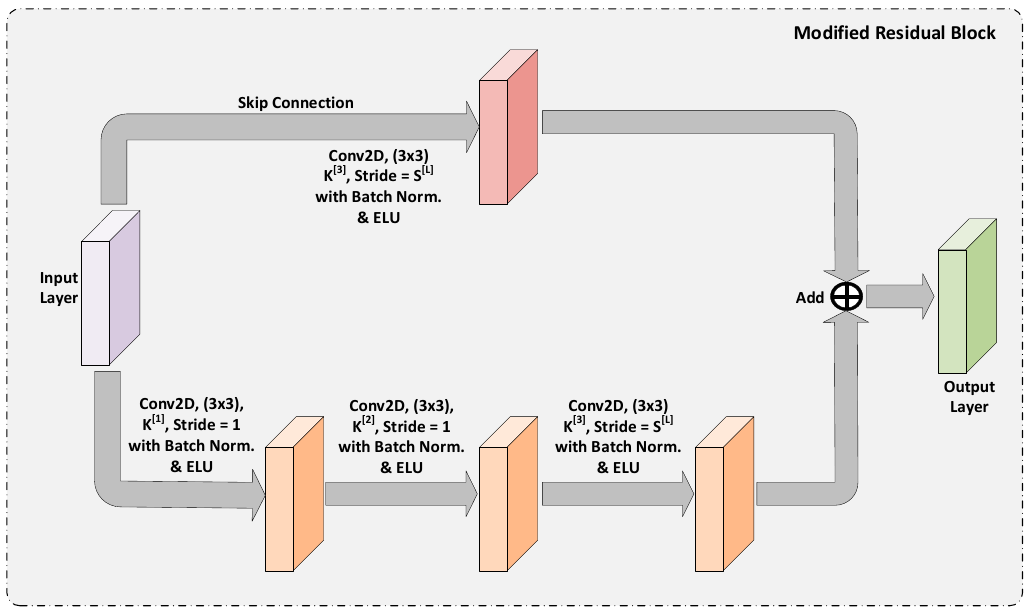
Figure 2. The overview of the Modified Residual Block.